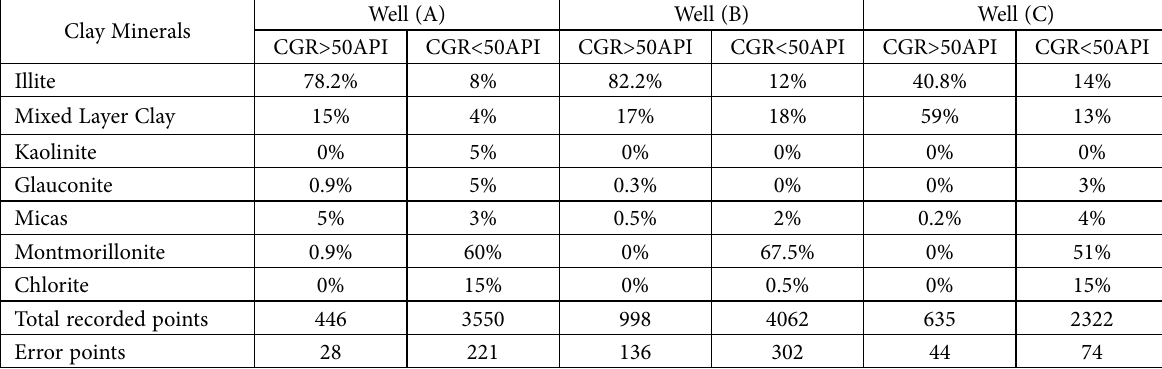
Table 2. Results of clay minerals identification cross plots in areas with high and low shale volume Clay